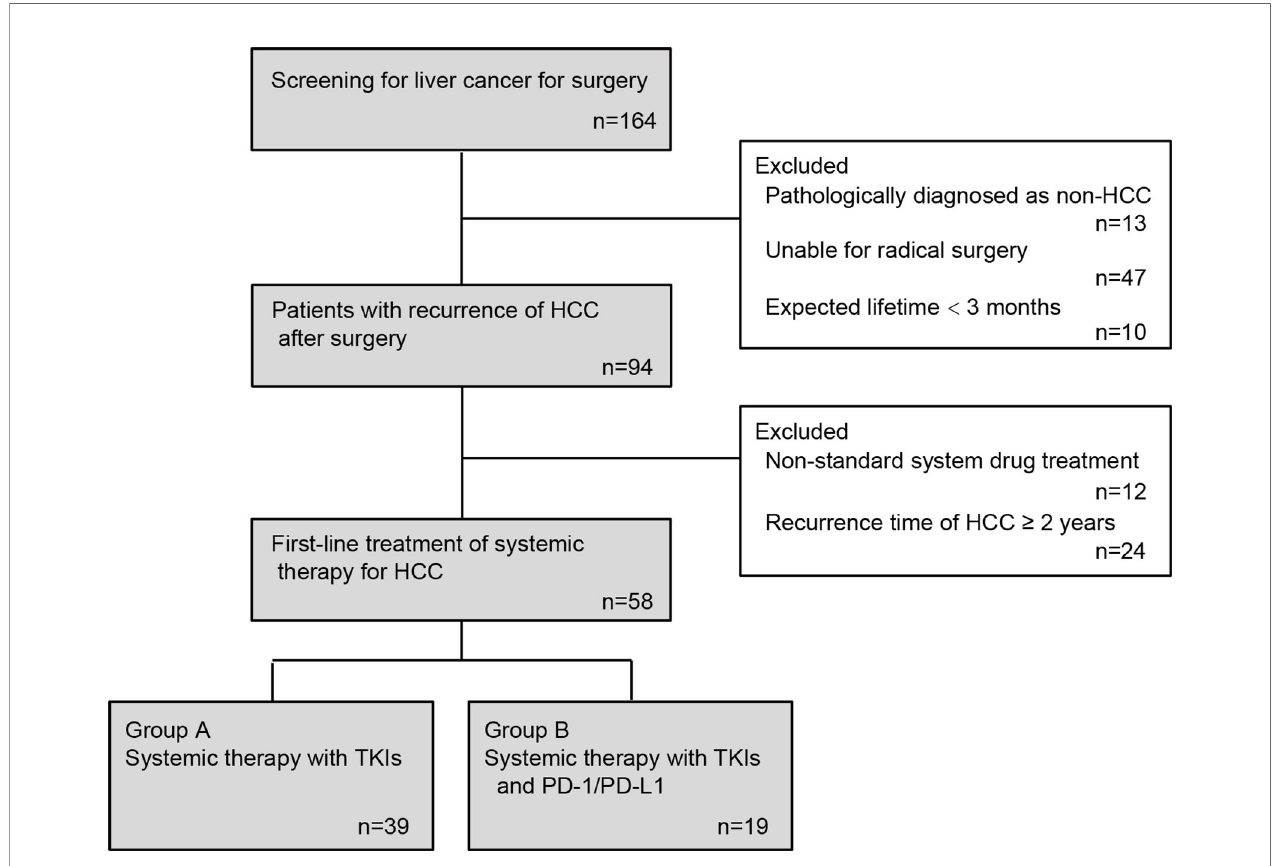
FIGURE 1 | Flow chart of patient